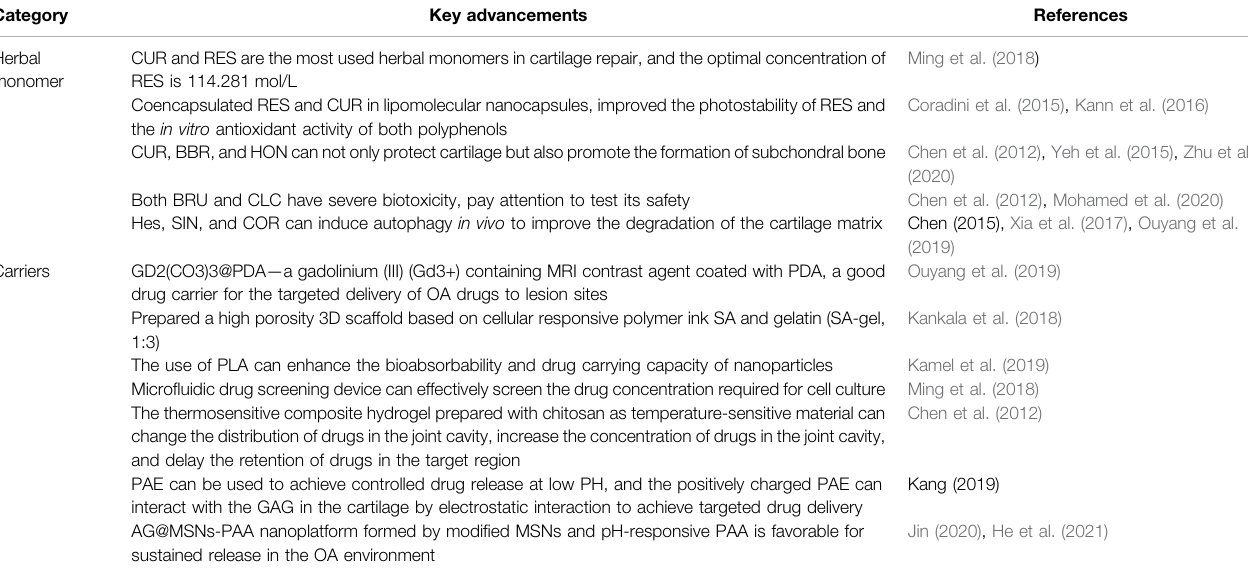
TABLE 6 | A summary of key advancements in the fi